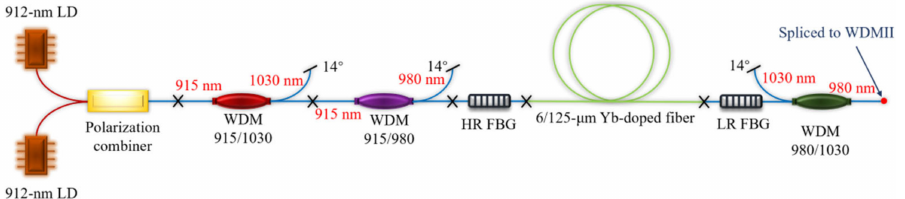
Figure 8. The experimental setup of the double-wavelength fiber oscillator.